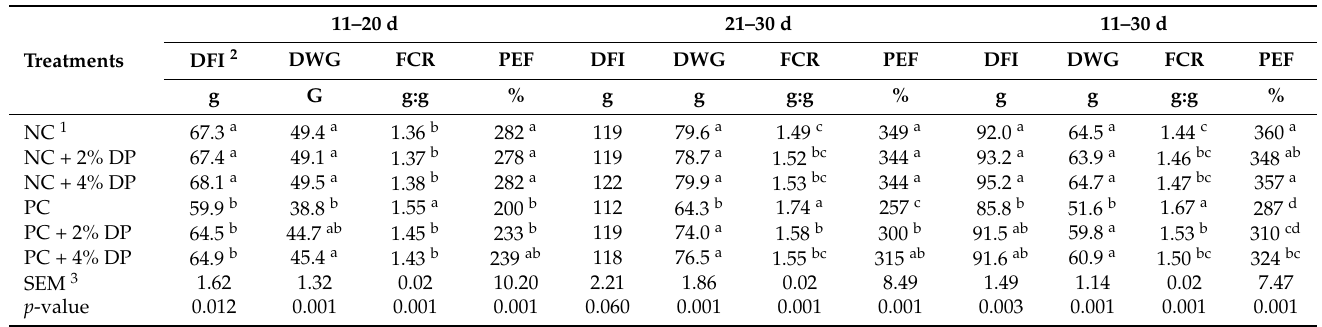
Table 2. Effect of adding two levels of date pits (DP) as aflatoxin adsorbent to aflatoxin B1 (AFB1)- contaminated diets on growth performance of broilers during grower (11–20 d), finisher (21–30 d), and overall (11–30 d) phases.